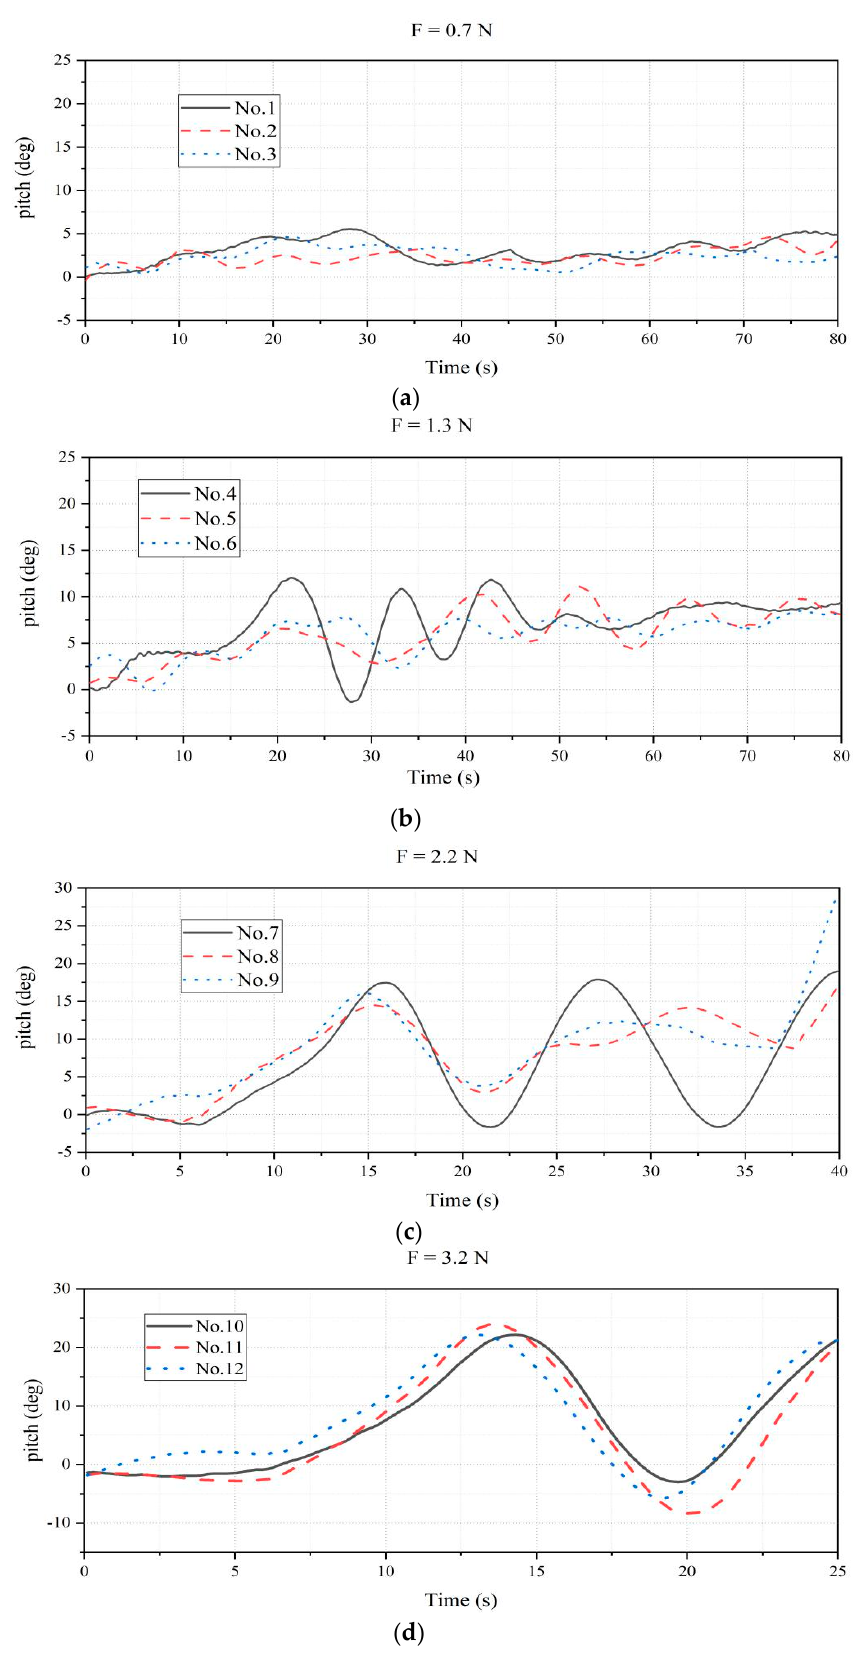
Figure 11. The pitch angle of horizontal motion experiments when F is ( a ) 0.7 N; ( b ) 1.3 N; ( c ) 2.2 N; ( d ) 3.2 N. ( d ) 3.2